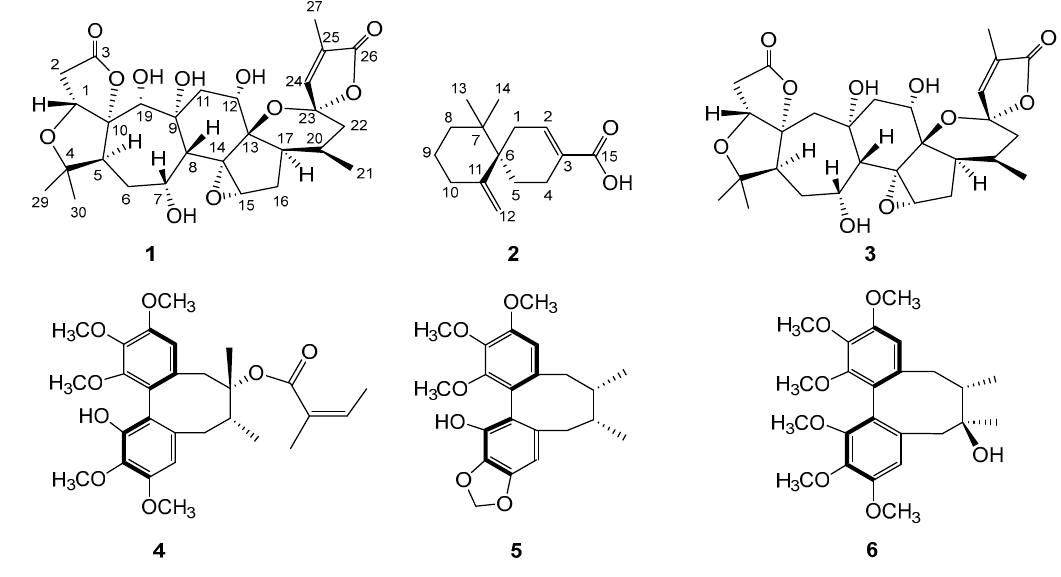
Figure 1. Structures of compounds 1 – 6 .